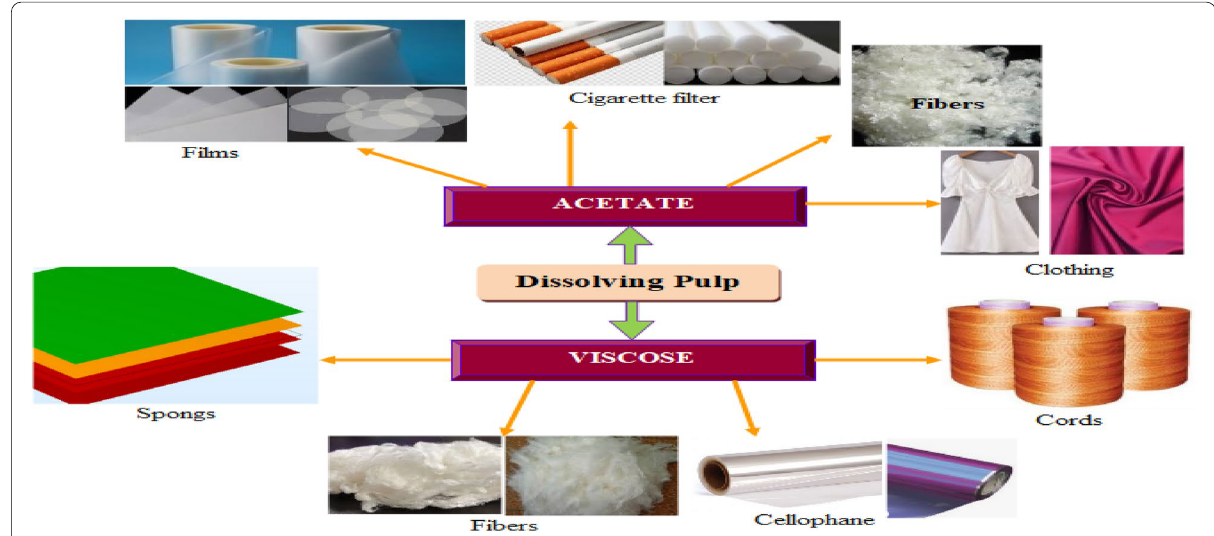
Fig. 13 Dissolving pulp beneficiation: regenerated